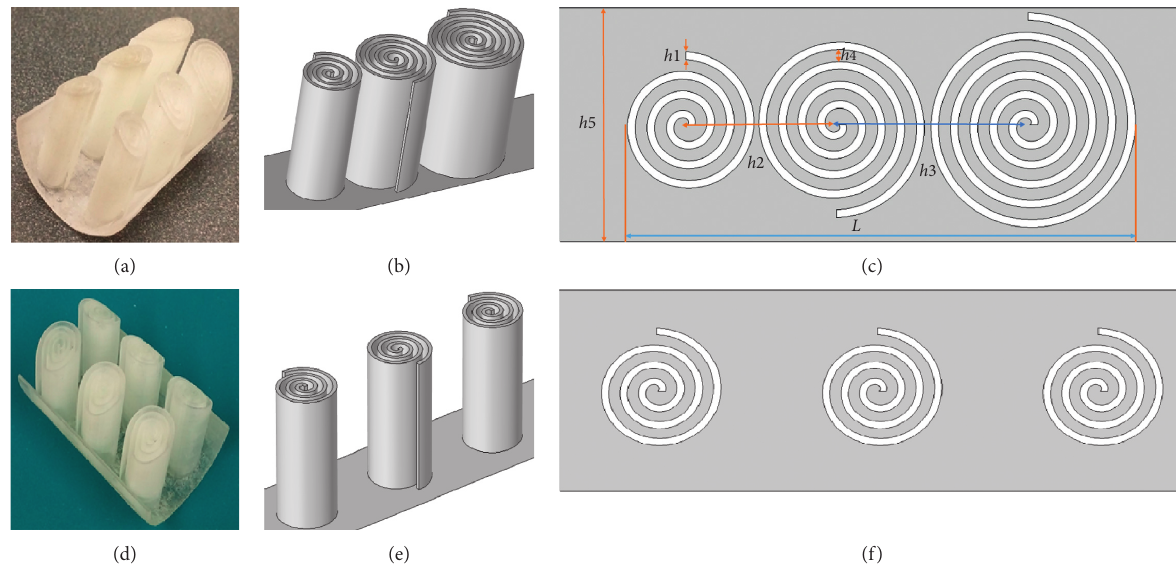
Figure 1: (a) The 3D-printed product for the varied-unit spiral array. (b) The corresponding 3D prototype model of (a). (c) The horizontal cross section and detailed dimensions of (a). (d) The 3D-printed product for the same spiral unit array. (e) The corresponding 3D prototype model of (d) but with the middle spiral reversed. (f) The horizontal cross section of (e).